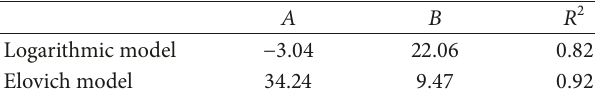
Table 3: Fitting information with logarithmic and Elovich